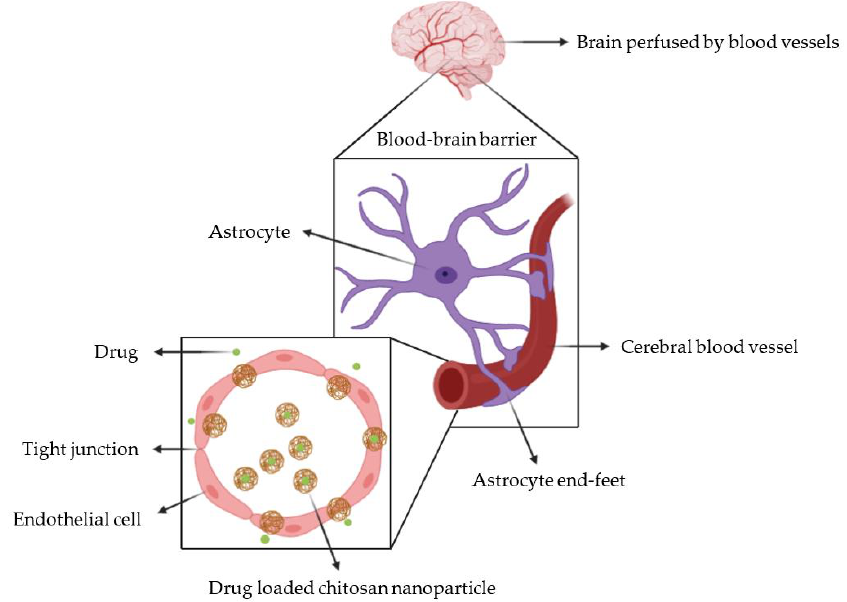
Figure 1. The cross-section of the cerebral blood vessel shows the interaction of drug loaded chitosan nanoparticles with the blood-brain barrier.